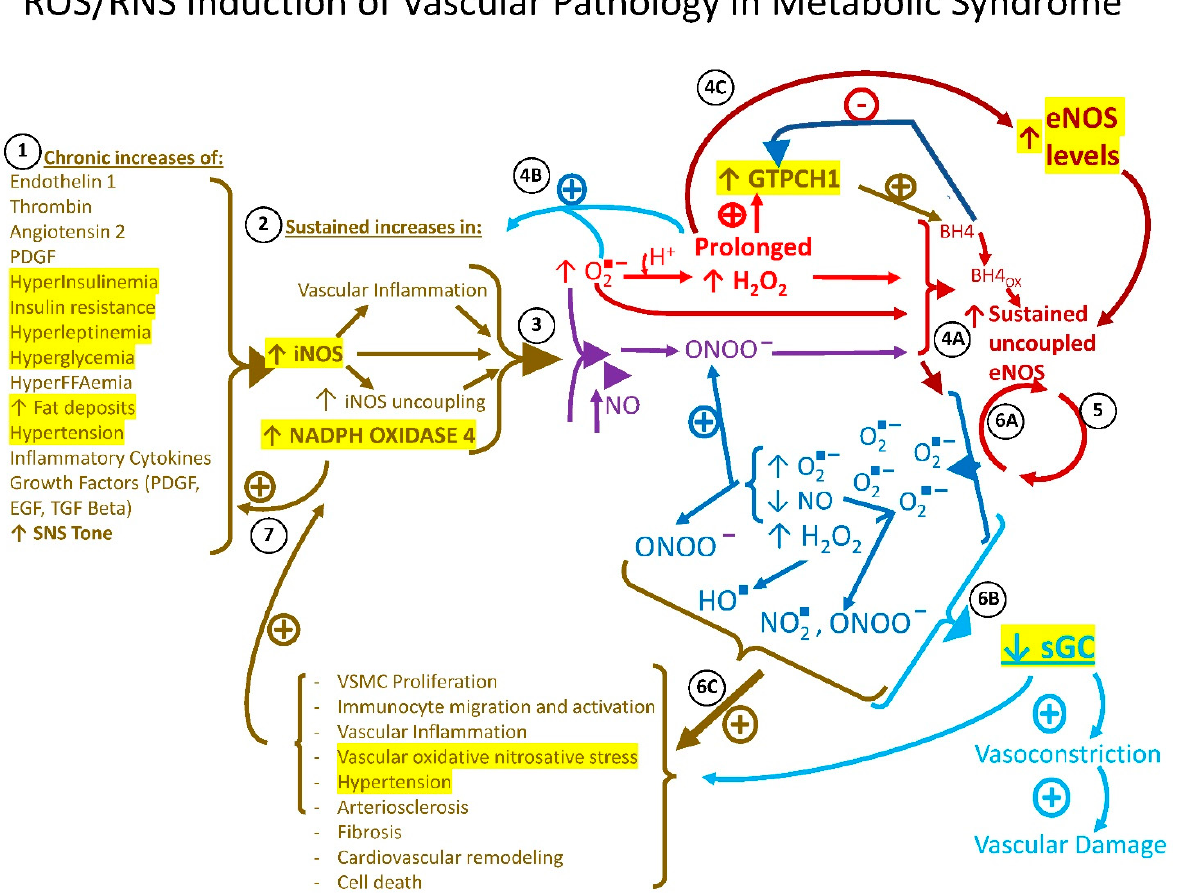
Figure 4. ROS/RNS induction of vascular pathology in metabolic syndrome. Chronic increases in several humoral, neural, and metabolic factors of metabolic syndrome listed in 1 potentiate sustained increases in the expressions of NADPH oxidase 4 and iNOS. 2 . Such increases in NADPH oxidase 4 and iNOS activities produce increases in oxygen free radical (O 2 − ) that can react with H + to form hydrogen peroxide (H 2 O 2 ) and with nitric oxide (NO) to form peroxynitrite (ONOO − ). 3 . All three of O 2 − , H 2 O 2 , and ONOO − lead to eNOS uncoupling via oxidation of tetrahydrobiopterin (BH 4 to BH 4ox (BH 2 )) and several other mechanisms. 4A . These ROS/RNS can also feedback to indirectly potentiate further increases in NADPH oxidase 4 and iNOS. 4B . Prolonged increases in H 2 O 2 stimulate an increase in eNOS expression that ultimately becomes uncoupled under the concurrent environment of increased ROS/RNS. 4C . The increased levels of uncoupled eNOS decrease its NO production and generate increased O 2 − levels that again react with H + and NO to form H 2 O 2 , ONOO − , hydroxyl radical (OH − ), nitrogen dioxide (NO 2 − ) and several other ROS/RNS species. 5 . These uncoupled eNOS-generated ROS/RNS feedback to uncouple more eNOS; 6A , and feedforward (in conjunction with decreased NO) to decrease the expression and activity of soluble guanylate cyclase (sGC), resulting in a decreased effect of the sGC product, cGMP, to promote vascular tissue vasodilation and health. 6B . These uncoupled eNOS-generated ROS/RNS products, along with those formed via increased NADPH oxidase 4 and iNOS feedforward to also directly cause damage to the vasculature (endothelium and smooth muscle cells) as listed in 6C . 7 . Inflammatory cytokines and growth factors from infiltrating immunocytes and proliferating vascular smooth muscle cells further stimulate NADPH oxidase 4 and iNOS and these enzymes also feedback to stimulate these same actions. The metabolic syndrome milieu initiates and maintains the vascular production of ROS/RNS via multiple internal positive feedback and feedforward lops that ultimately lead to vascular damage and CVD. Prolonged increases in H 2 O 2 production from NADPH oxidase 4, iNOS, and uncoupled eNOS stimulate the increased expression of GTPCH 1, the rate-limiting enzyme in BH 4 synthesis, and BH 4 is itself an end product, negative feedback inhibitor of GTPCH 1. As BH 4 becomes oxidized by the prevailing ROS/RNS stress, less of it is available to inhibit GTPCH 1. Increased levels of GTPCH 1 are a biomarker of tissue pro-oxidative/nitrosative and proinflammatory state. NO 2 − —nitrogen dioxide; OH − —hydroxyl radical; PDGF—platelet-derived growth factor; EGF—epidermal growth factor; TGF β —transforming growth factor beta; SNS—sympathetic nervous system; VSMC—vascular smooth muscle cell; BH 4 — tetrahydrobiopterin; BH 4 ox —oxidized tetrahydrobiopterin; ↑ —increases; ↓ —decreases; ⊕ —stimulates; ⦵ —inhibits; ⤻ , ⤹ , ↗ , → , ↘ , ⤸ , ⤣ , ⤤ , ⤴ , ⤷ leads to; } ► , } ► { collectively leads to these collective events. Enzyme levels and cardiometabolic parameters measured in the study are highlighted in yellow.